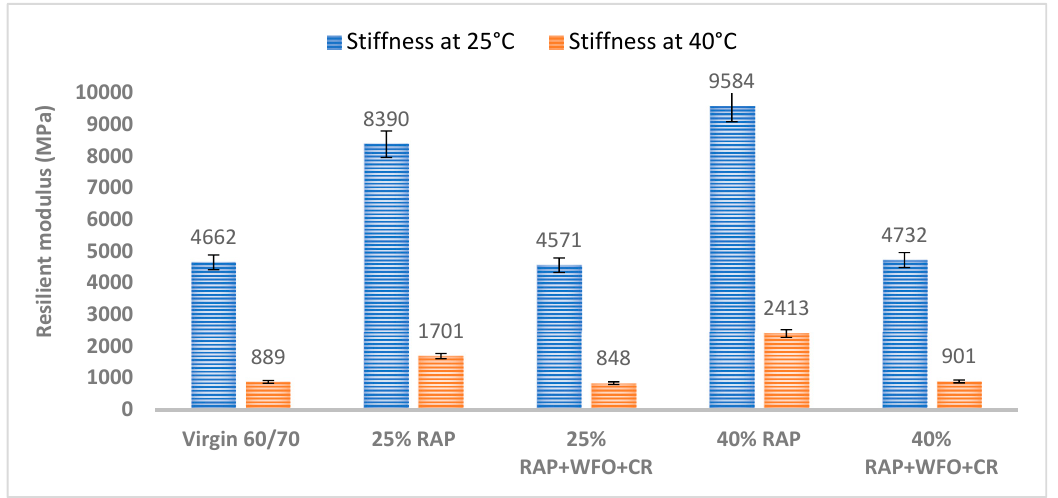
Figure 4. Resilient modulus of the virgin asphalt, RAP and the recycled asphalt mixture at different temperatures. The higher resilient modulus at 25 ◦ C indicates that the asphalt mixture containing RAP had higher stiffness than the virgin asphalt. The asphalt mixtures containing 25% and 40% RAP had a resilient modulus of 8390 and 9584 MPa, which was 44.4% and 51% higher than the virgin asphalt. Izaks et al. [6] obtained similar results, where adding higher RAP percentages in the asphalt mixture resulted in higher stiffness and resilient